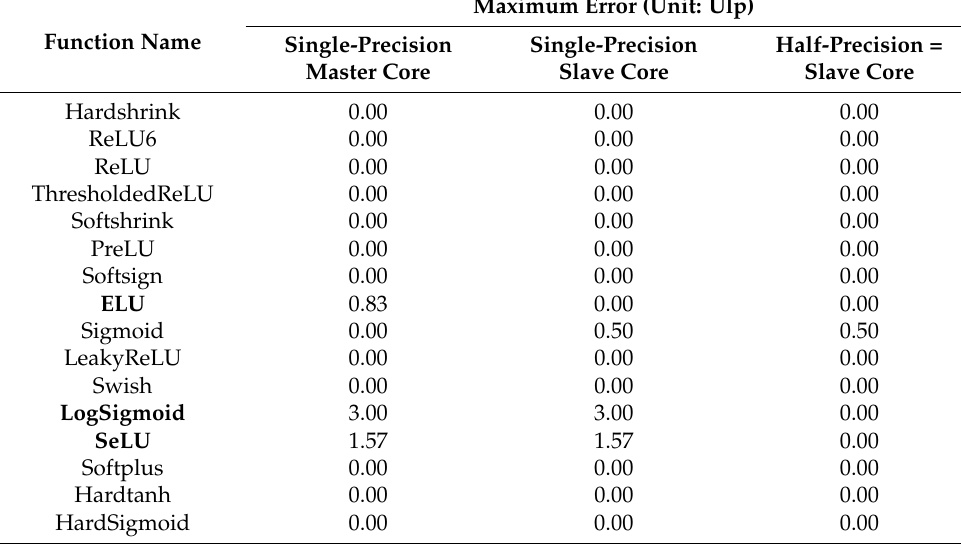
Table 5. Test environment.